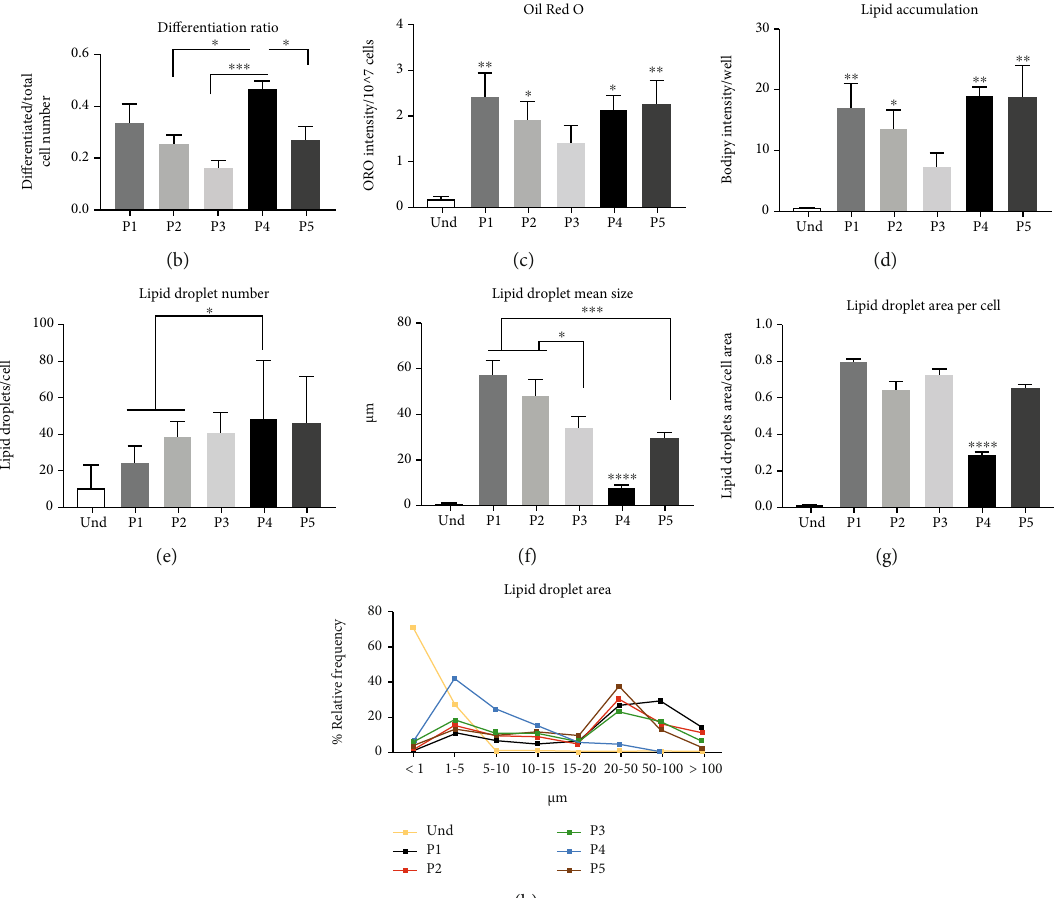
Figure 1: E ff ect of the di ff erentiation protocols on di ff erentiation capacity, lipid accumulation, and lipid droplet morphology. (a) Human adipose-derived stem cells were di ff erentiated for 21 days with fi ve adipogenic di ff erentiation protocols. Cells were stained with Bodipy and imaged with 5x magni fi cation for di ff erentiation ratio calculation and with 63x magni fi cation for lipid accumulation and lipid droplet morphology with a PerkinElmer Opera Phenix confocal microscope. Cells were stained with Oil Red O for lipid accumulation measurement and imaged at 10x magni fi cation with a Nikon Eclipse TS100 bright fi eld microscope. Cells were imaged with a 1500x magni fi cation JEOL JEM-1400 electron microscope for lipid droplet morphology. (b) The population of di ff erentiated cells was calculated using Harmony software as a ratio of di ff erentiated cells stained with Bodipy to total cell number based on nuclear staining with Hoechst 33342. (c) Oil Red O was eluted, absorbance was measured at 510nm, and results were normalized to the cell number measured with Cytation5 after nuclear staining with Hoechst 33342. (d) Lipid accumulation per well was measured by quanti fi cation of Bodipy green intensity per cell population with Harmony software. Quanti fi cation of (e) lipid droplet number, (f) lipid droplet mean size, and (g) lipid droplet area per cell was imaged by transmission electron microscopy (TEM) and analyzed with the Microscopy Image Browser (MIB). (h) Relative frequencies of lipid droplet by size analyzed with MIB. hASC3 was used for TEM analysis. For each condition, at least 200 lipid droplets (80 lipid droplets for undi ff erentiated cells) were analyzed. Statistical analysis was performed using one-way ANOVA followed by Tukey ’ s post hoc analysis ( n = 6 ): ∗ p < 0 : 05 , ∗∗ p < 0 : 01 , ∗∗∗ p < 0 : 001 , and ∗∗∗∗ p < 0 : 0001 . Error bars are shown as SEM. The statistical di ff erences in (c) and (d) indicate a comparison to undi ff erentiated hASCs, whereas that in (g) indicates a comparison with all the other